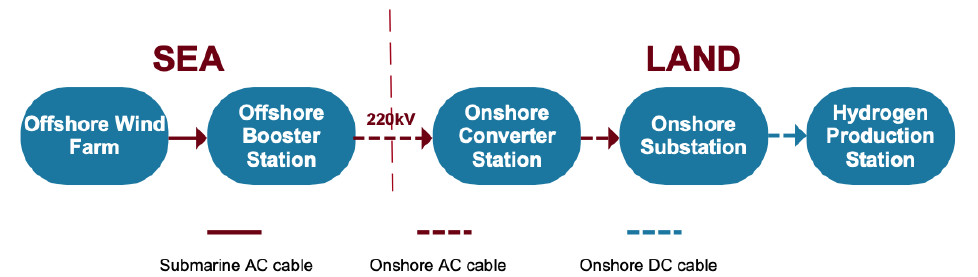
Figure 2. Topology of onshore hydrogen generation system for offshore wind power via AC trans- mission.